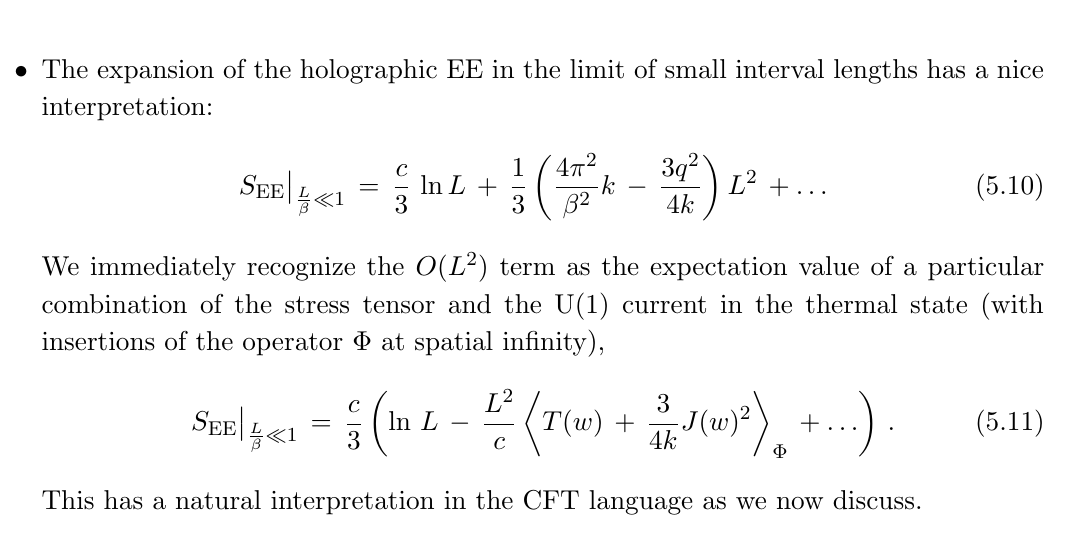
(cid:25) 2 k 2 (cid:12) (cid:0) 2 3